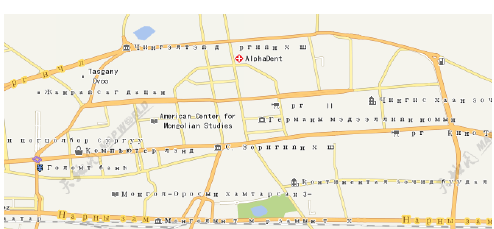
Figure 3. Cyrillic Mongolian place names in Ulaanbaatar, Mongolia